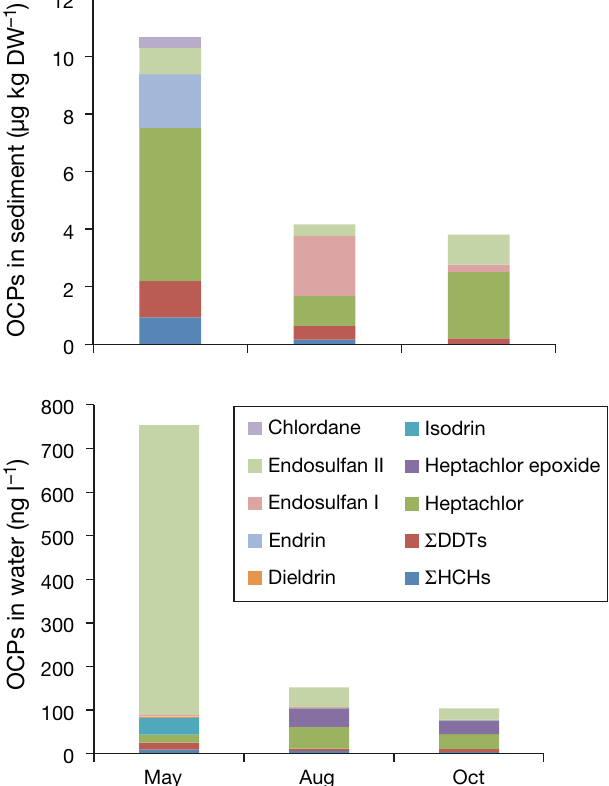
Fig. 2. Distribution and concentration of total organochlorine pesticides (OCPs) in (A) sediment and (B) water from the Honghe Hani Rice Terraces. DDT: dichlorodiphenyl tri - chlorothanes; HCJs: hexachlorocyclohexanes; DW: dry